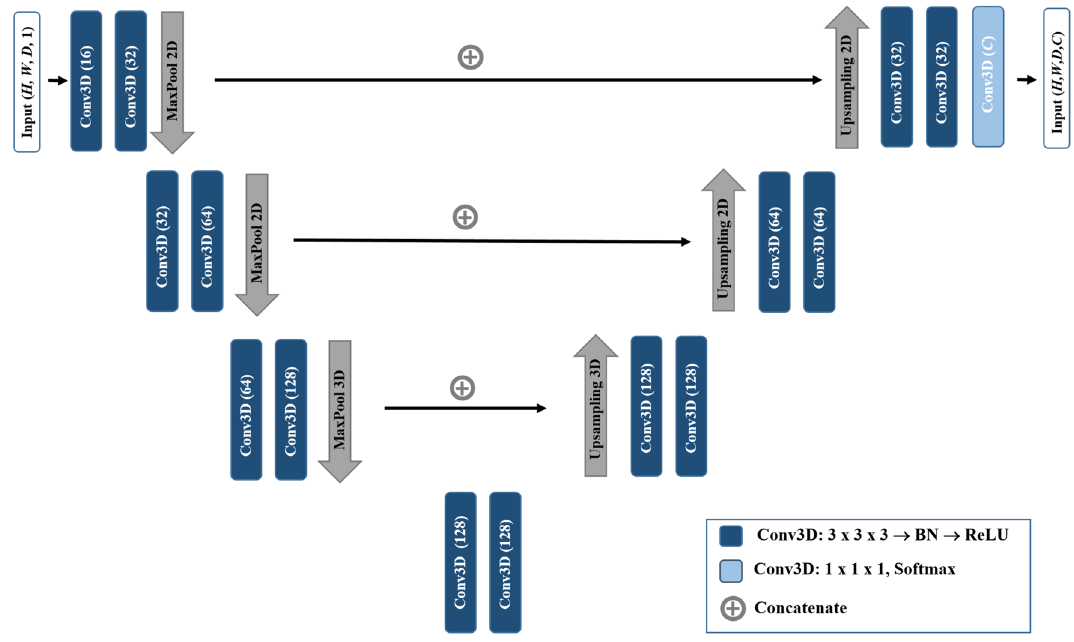
Figure 6. Anisotropic network architecture with settings for the prostate structure segmentation. The numbers in the brackets in the convolutional layers correspond to the number of feature maps returned by the convolutional